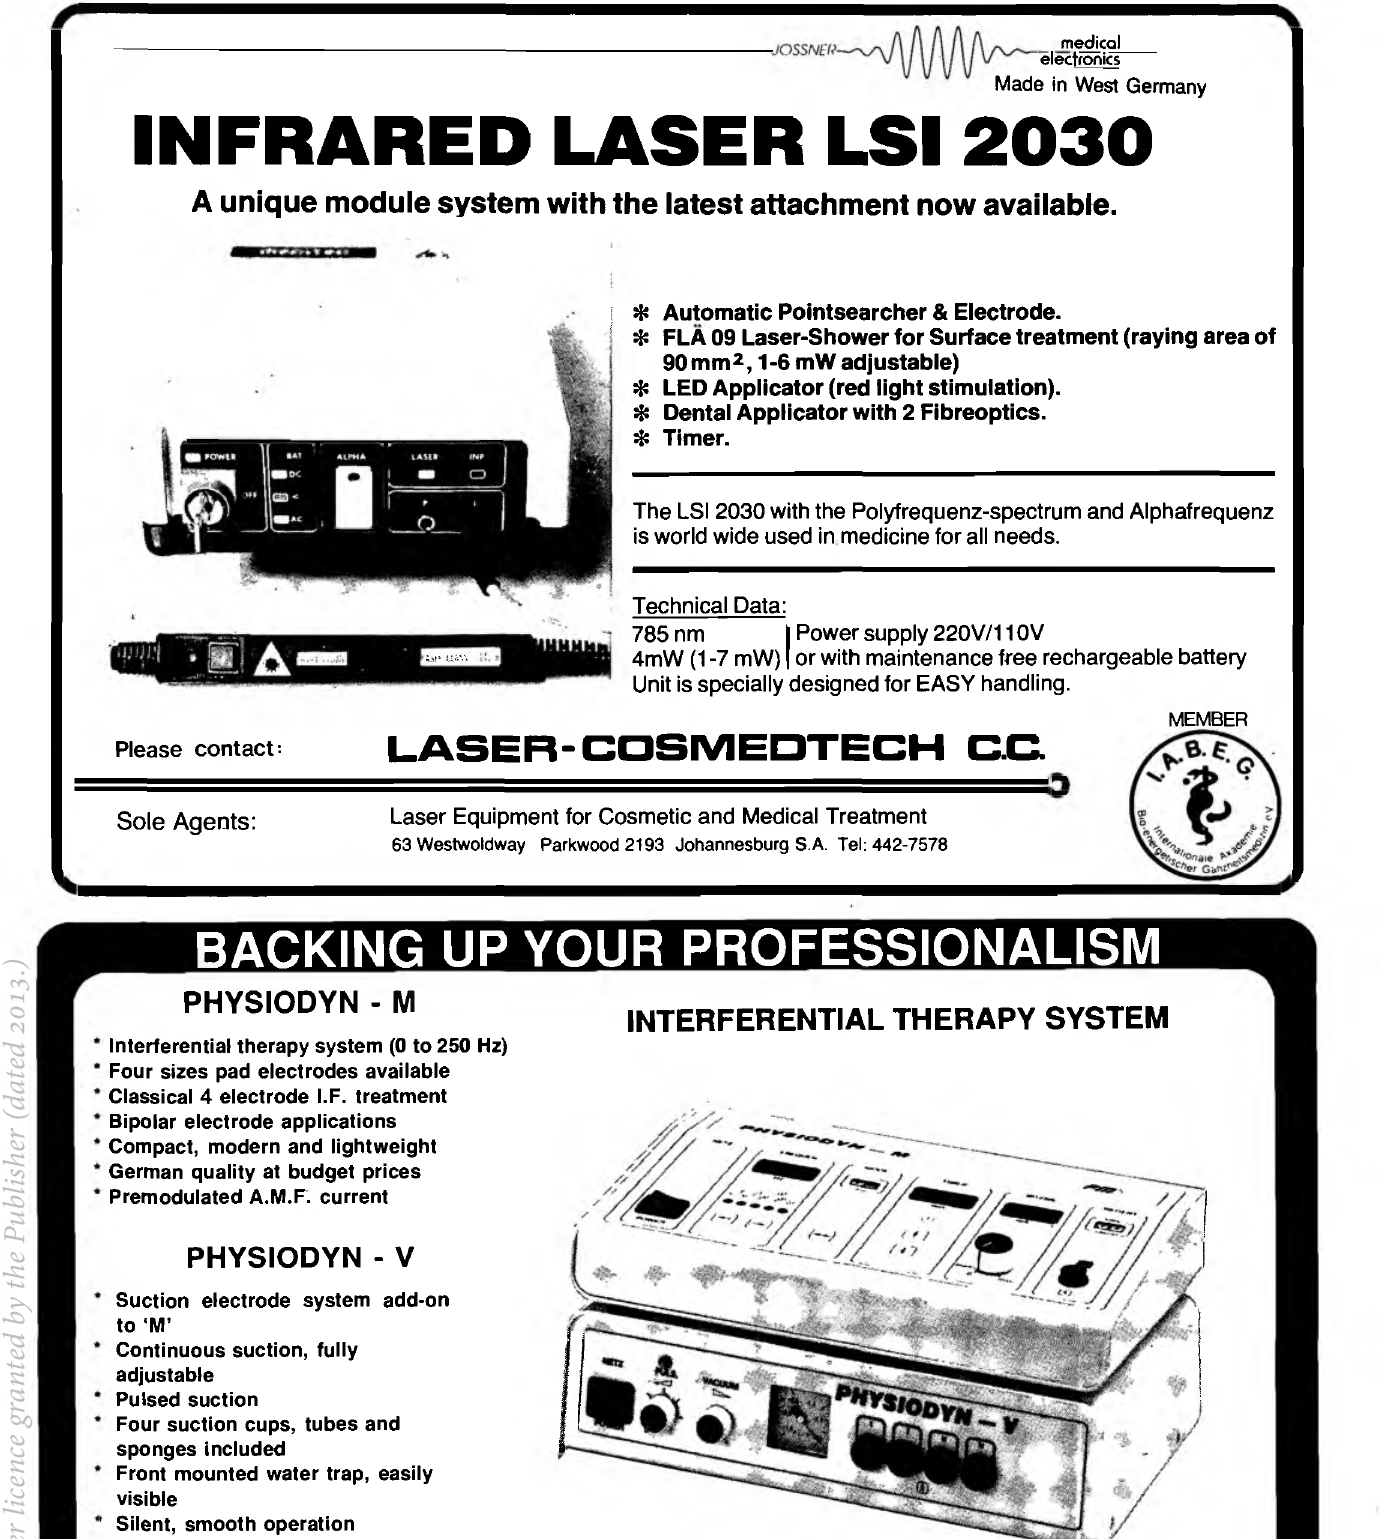
Four sizes pad electrodes available Classical 4 electrode I.F. treatment Bipolar electrode applications Compact, modern and lightweight German quality at budget prices Premodulated A.M.F.